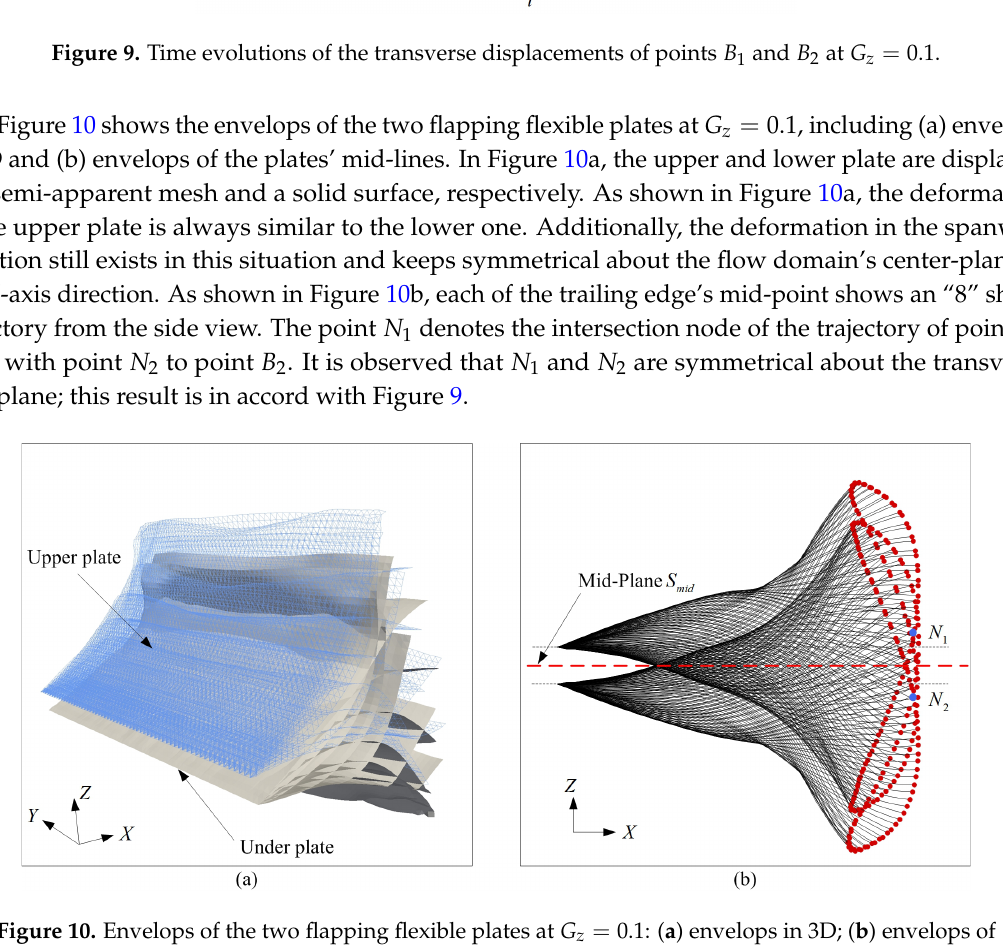
Figure 10. Envelops of the two flapping flexible plates at G z = 0.1: ( a ) envelops in 3D; ( b ) envelops of the plates’